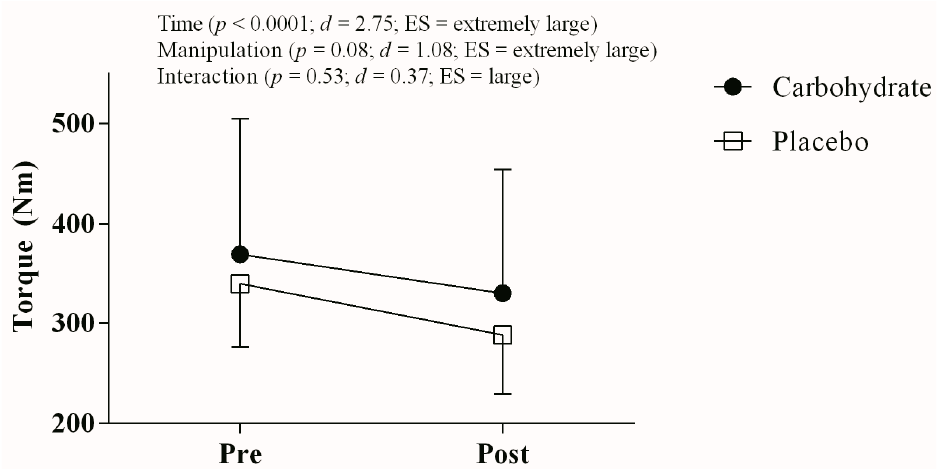
Figure 2. Torque responses measured before and after TT 4km in carbohydrate (filled circles) and placebo mouth rinse (open squares).